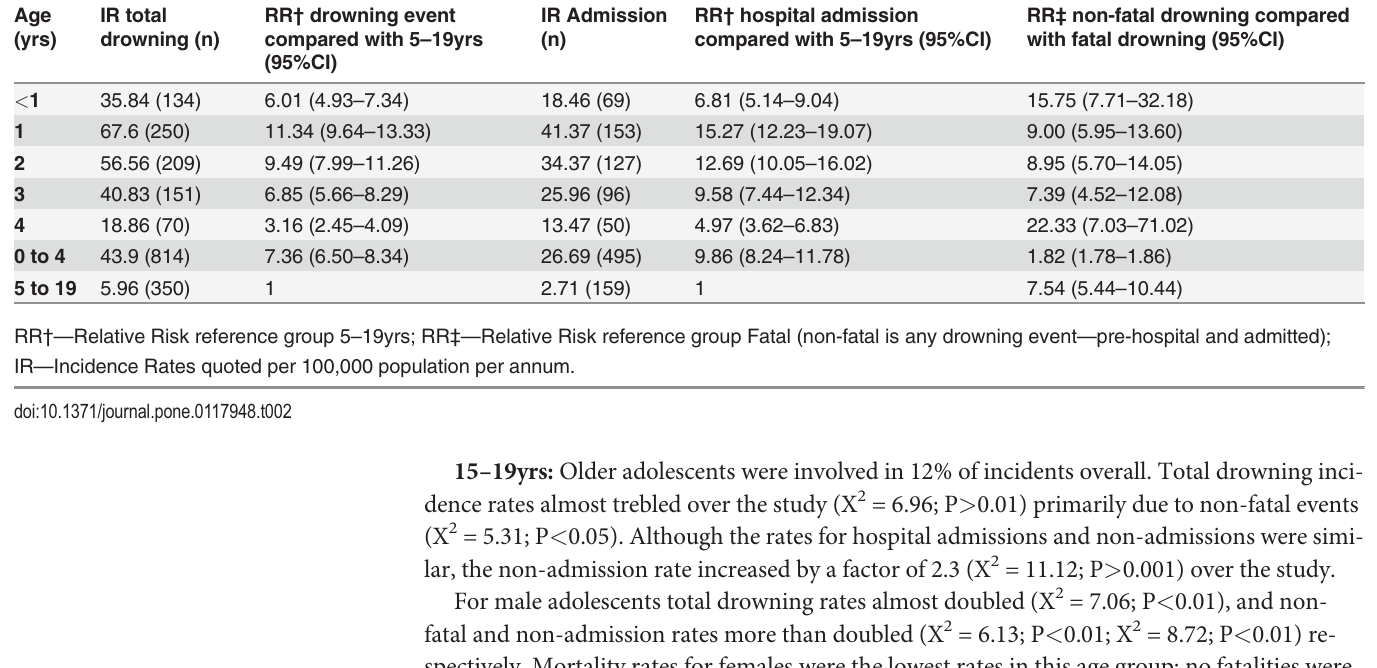
Table 2. Relative risk of drowning by age for total drowning and hospital admission, Queensland residents 2002 –